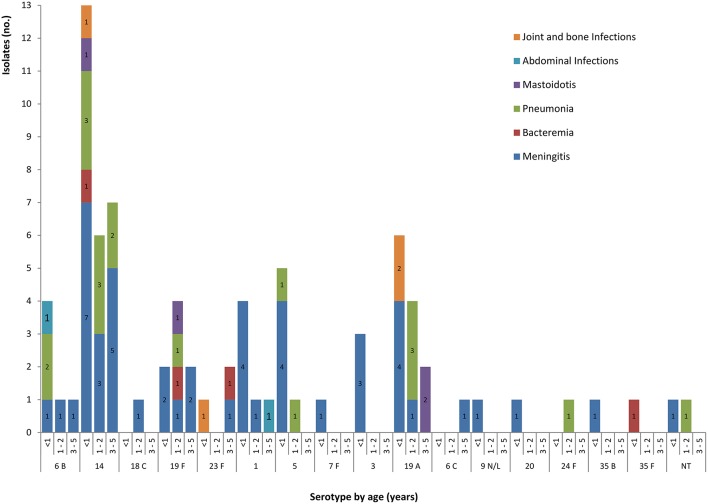
Serogroup/types distribution and age groups in children under 5 years old according to clinical presentations of invasive pneumococcal disease (IPD) episodes. Abdominal infections, S. pneumoniae was isolated from ascitic and peritoneal fluids; NT, non-typeable.